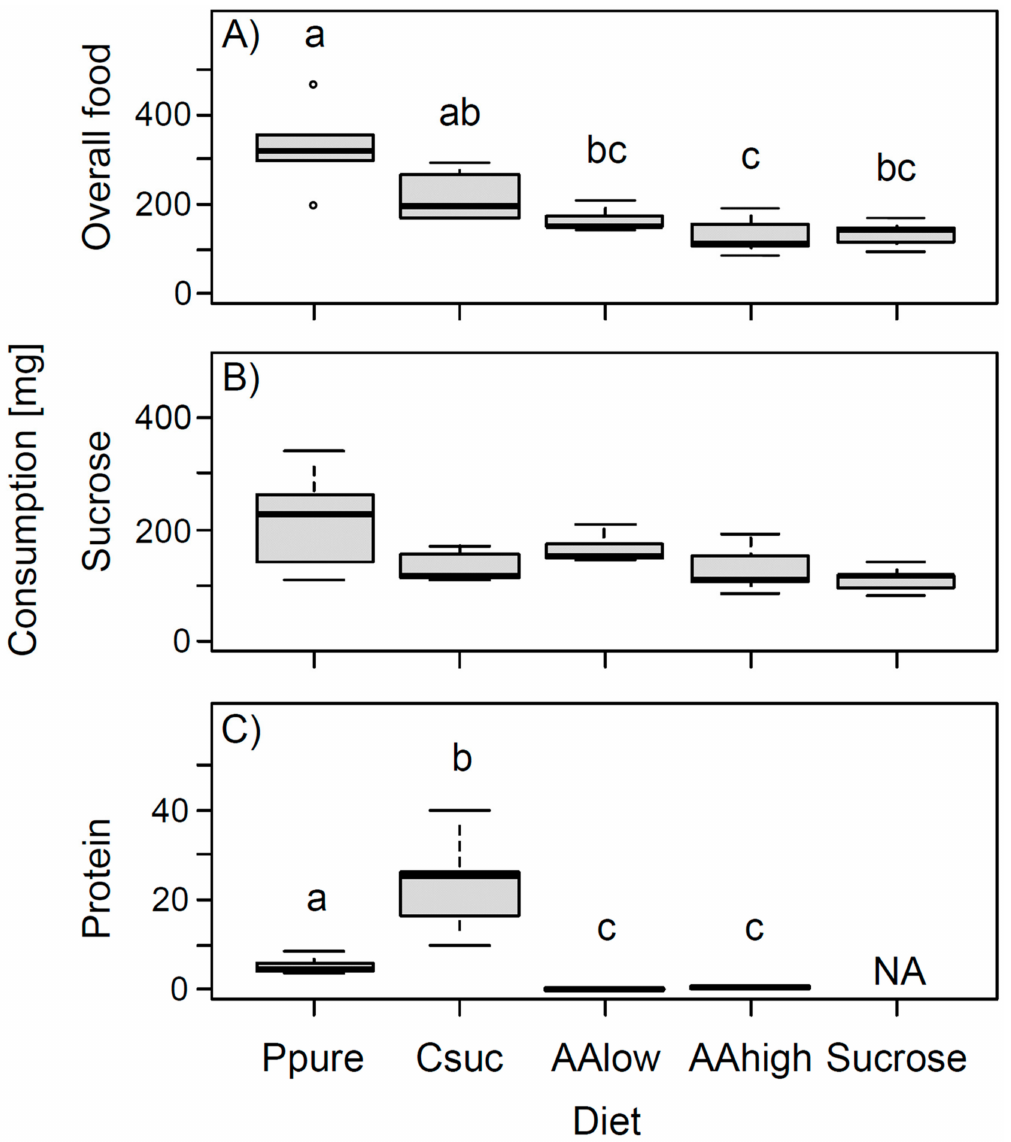
Figure 1. Daily individual consumption (in mg) of ( A ) overall food (including food consumed from petri dishes and from 60% sucrose solutions (with or without amino acids)), ( B ) sucrose (from the 60% sucrose solution plus sucrose from the casein-sucrose mixture), and ( C ) protein (from either pollen, casein, or amino acid mixtures). Di ff erent letters indicate significant di ff erences between diets based on Tukey post hoc tests for analyses significant after Bonferroni correction. Abbreviations as follows: Ppure, pure pollen; Csuc, casein-sucrose; AAlow, 60% sucrose solution with concentrations of essential amino acids and proline as can be found in some Fabaceae species; AAhigh, 60% sucrose solution with amino acids at a 100 times higher concentration; Sucrose = only sucrose solution (60% by mass); NA, no data